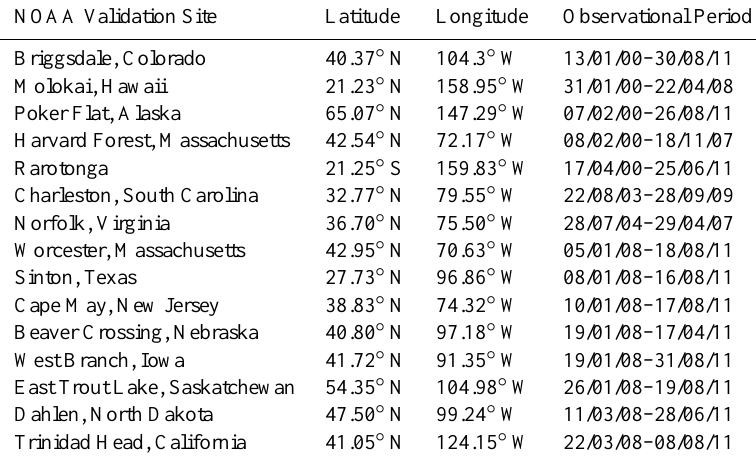
Table 1. NOAA Validation Sites for in-situ CO profiles ∗ .